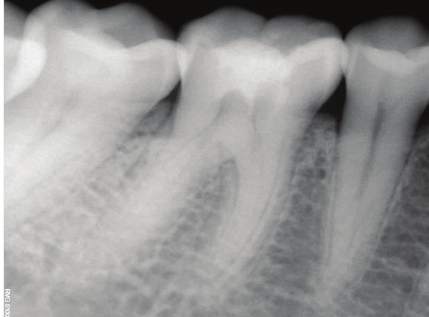
Figure 38: Immediate postoperative RVG 36.